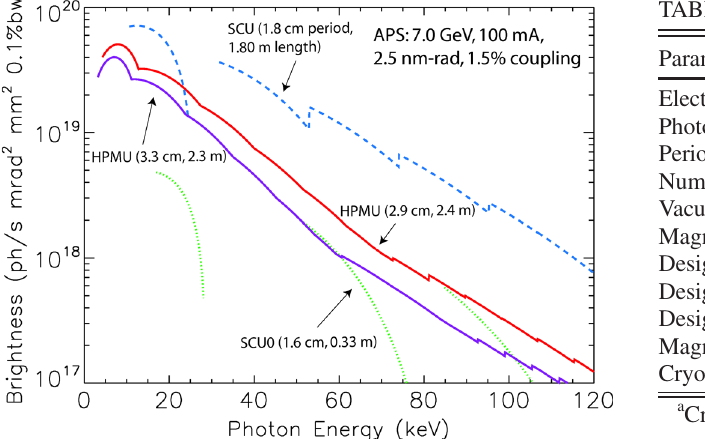
FIG. 1. The x-ray brightness as a function of photon energy for two hybrid permanent magnet undulators and two superconduct- ing undulators. The period length and the magnetic length of each device are given in the figure.